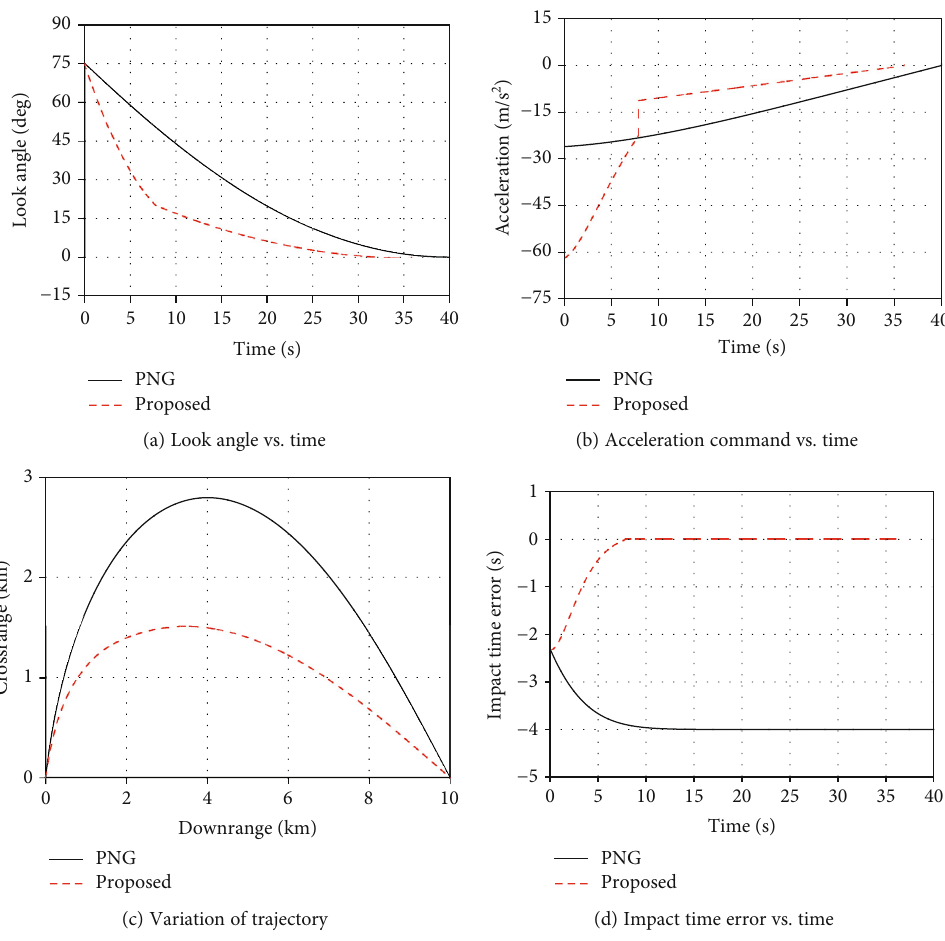
Figure 2: Simulation results for the case ξ